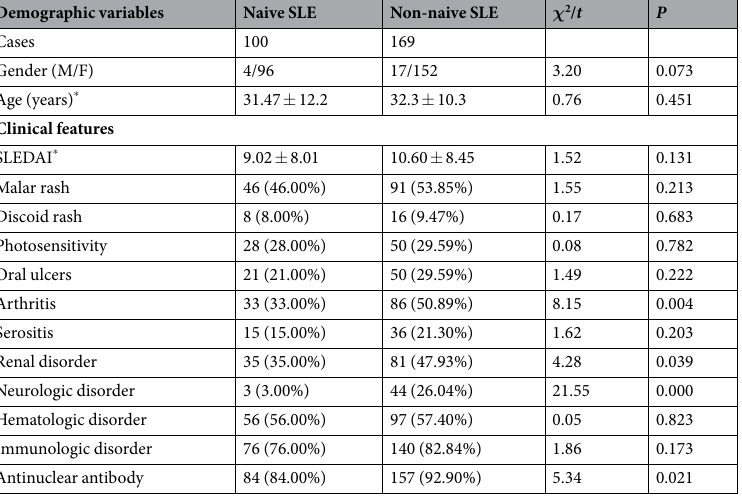
Table 1. Demographic and clinical characteristics of SLE patients. * Statistical analysis of age and SLEDAI adopted independent-sample